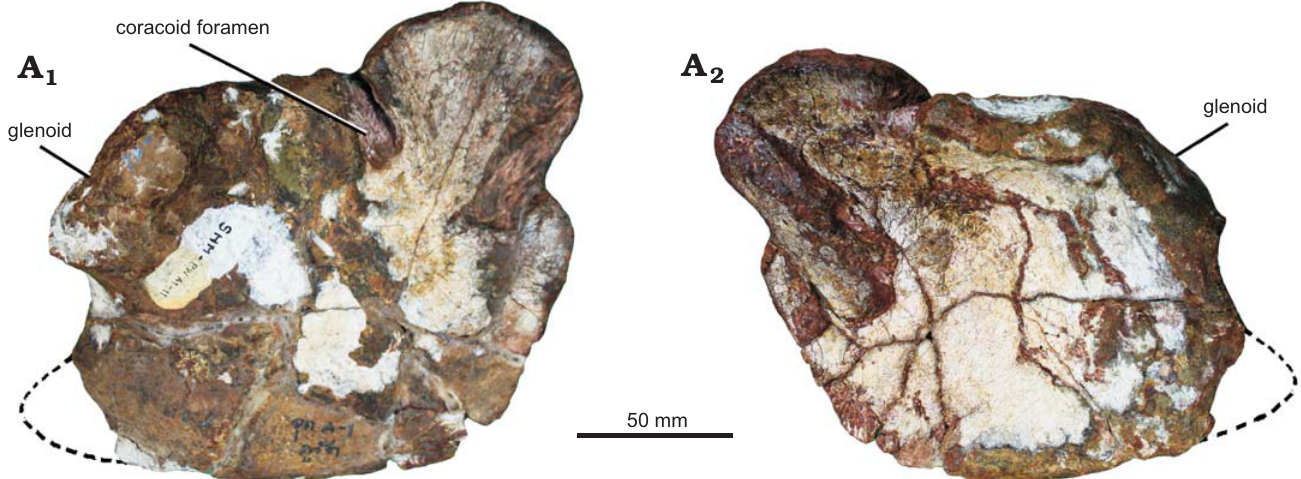
Fig. 15. Coelurosaurian theropod Vayuraptor nongbualamphuensis gen. et sp. nov. from the Early Cretaceous Sao Khua Formation of Phu Wat, Nong Bua Lamphu Province, Thailand. PRC-NB A1-11, right coracoid in lateral (A 1 ) and medial (A 2 ) views. Dashed lines are the reconstruction of the posteroven- tral process of the